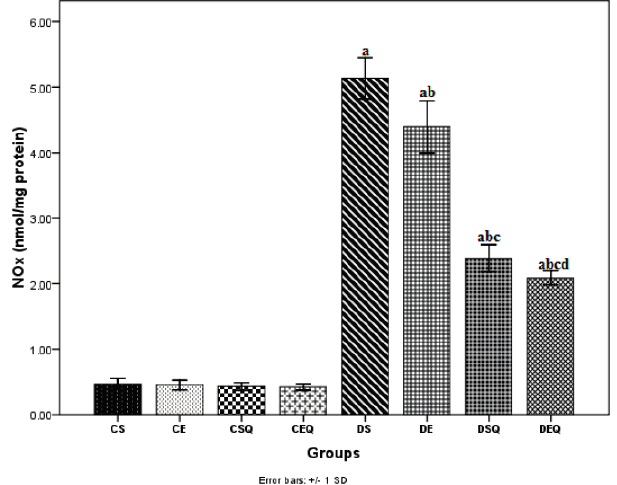
Figure 5. The effects of quercetin and moderate exercise training on the level of nitrite plus nitrate production (NOx) (nmol/mg protein) in the thoracic aortic tissue homogenates of control and diabetic rats. Results are the means ± SD for ten animals each group, defined as in the caption of Figure 1. Statistically significant differences are indicated by the symbols: a p < 0.05 vs. CS group, b p < 0.05 vs. DS group, c p < 0.05 vs. DE group and d p < 0.05 vs. DSQ